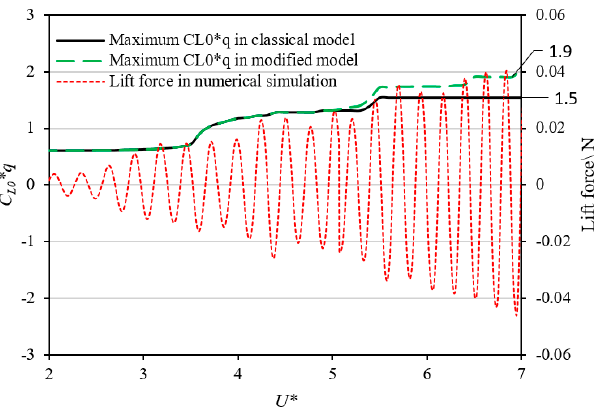
Figure 9. Change trend of C L 0 *q in different models and the lift force versus reduced velocity ( m * = 2.36, m * ζ = 0.014).